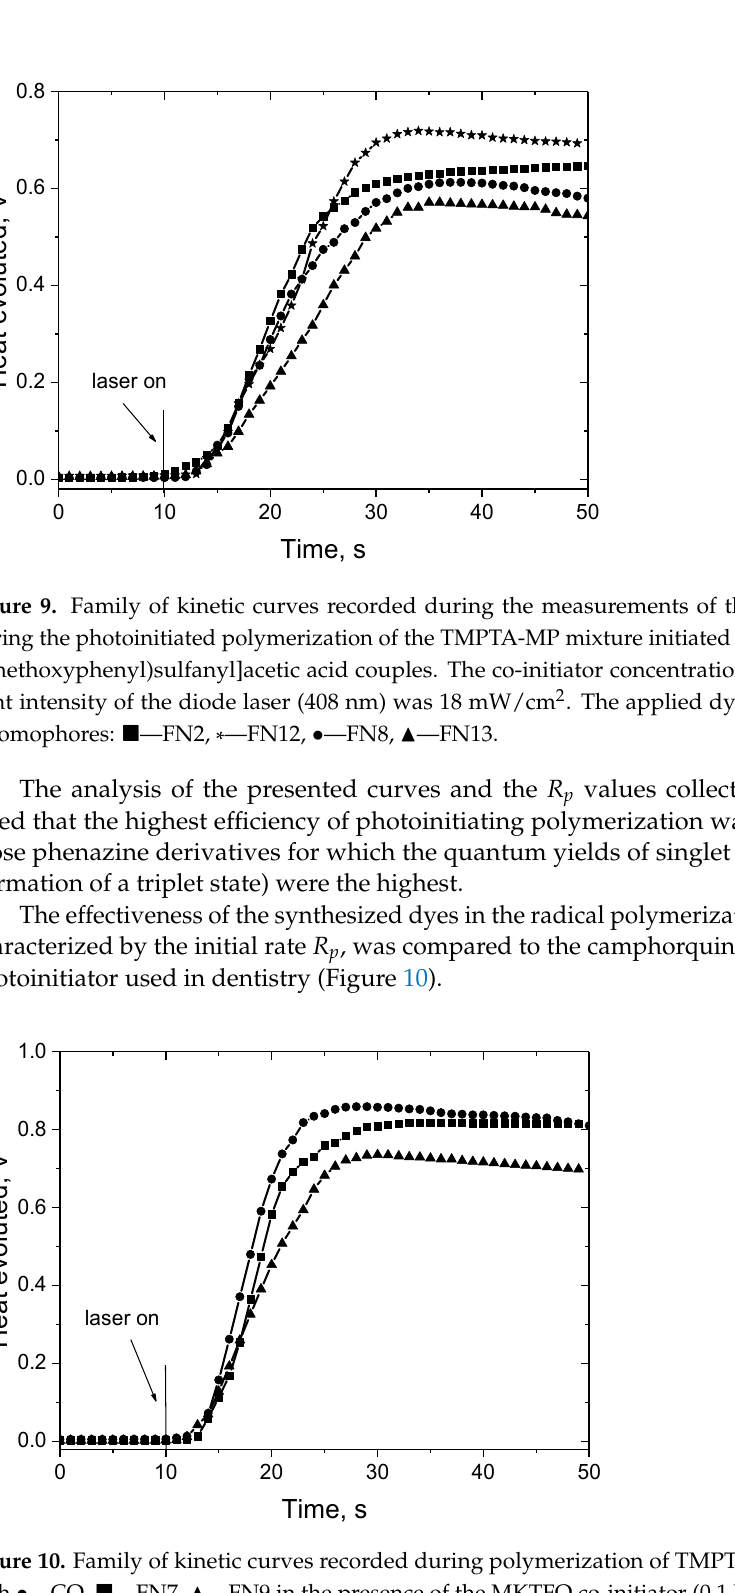
Figure 10. Family of kinetic curves recorded during polymerization of TMPTA-MP photoinitiated with ● —CQ, ■ —FN7, ▲ —FN9 in the presence of the MKTFO co-initiator (0.1 M); the light intensity of diode laser (408 nm) was 18 mW/cm 2.